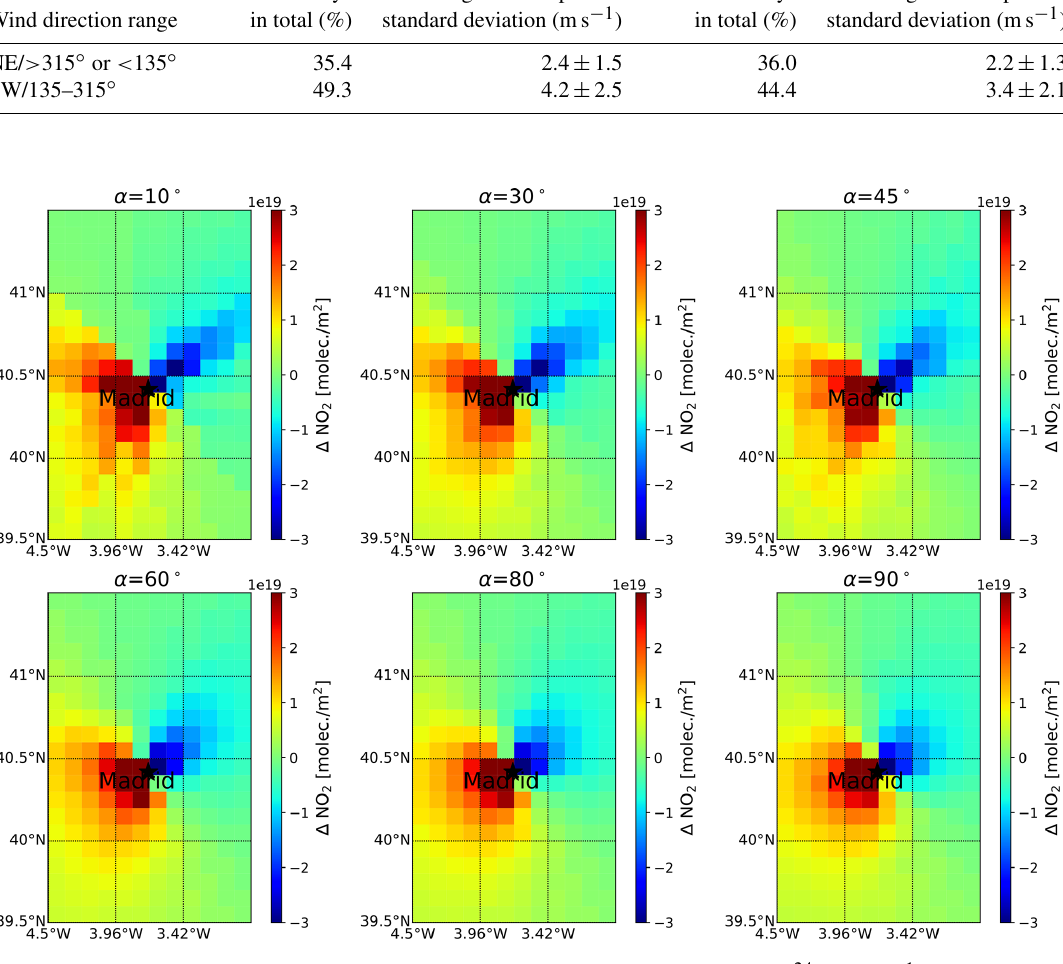
Figure A1. Examples of wind-assigned NO 2 plume based on the simple plume model ( ε = 5 . 0 × 10 24 molec.s − 1 ) using Madrid as the point source in the NE–SW direction on a 0.1 ◦ × 0.135 ◦ latitude–longitude grid with a different opening angle ( α ) from 10 to 90 ◦